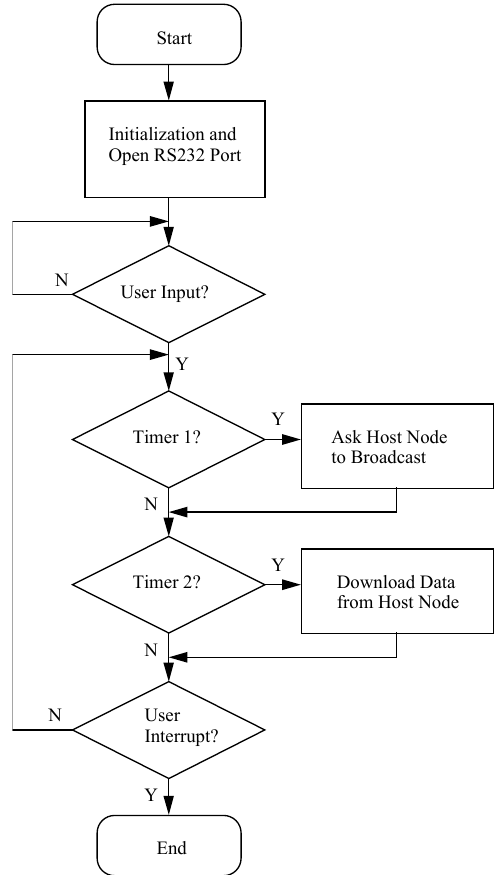
Figure 7. The operation of the host computer